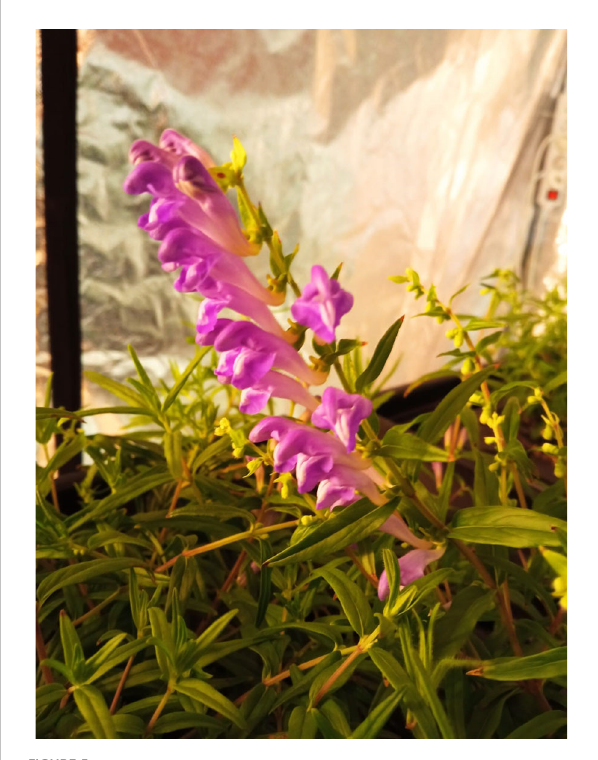
FIGURE 5 One of the fi rst plants to blossom shown in full bloom from E = 1.25 kV/cm, t = 100 m s, N = 10